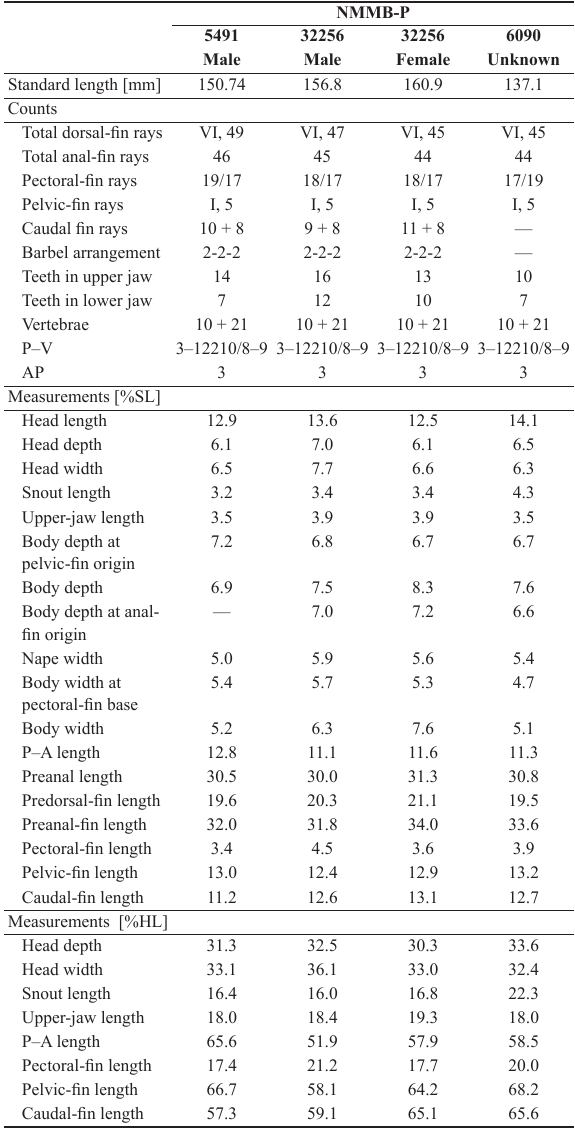
Table 1. Counts and measurements of Taenioides snyderi from Taiwan.